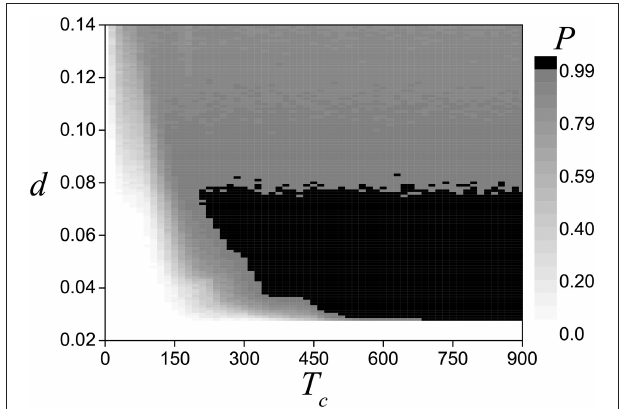
FIGURE 9 | Dependence of establishing probability of high-amplitude oscillations in the pair of short-term coupled elements [system (3)] for initial conditions such as ( I . C .) 1 on the parameters ( d , T c ). Parameters values: a = 0.32, b = 0.79, c = 1.166, and ε =